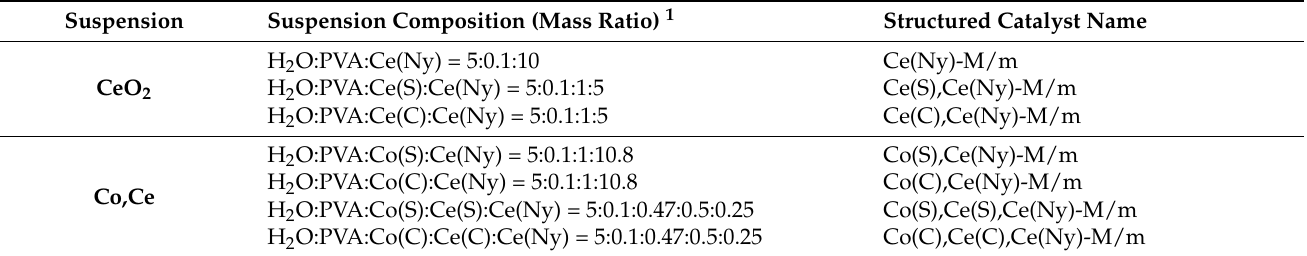
Table 5. Mass ratio of the different suspensions prepared, and the naming of the obtained struc- tured